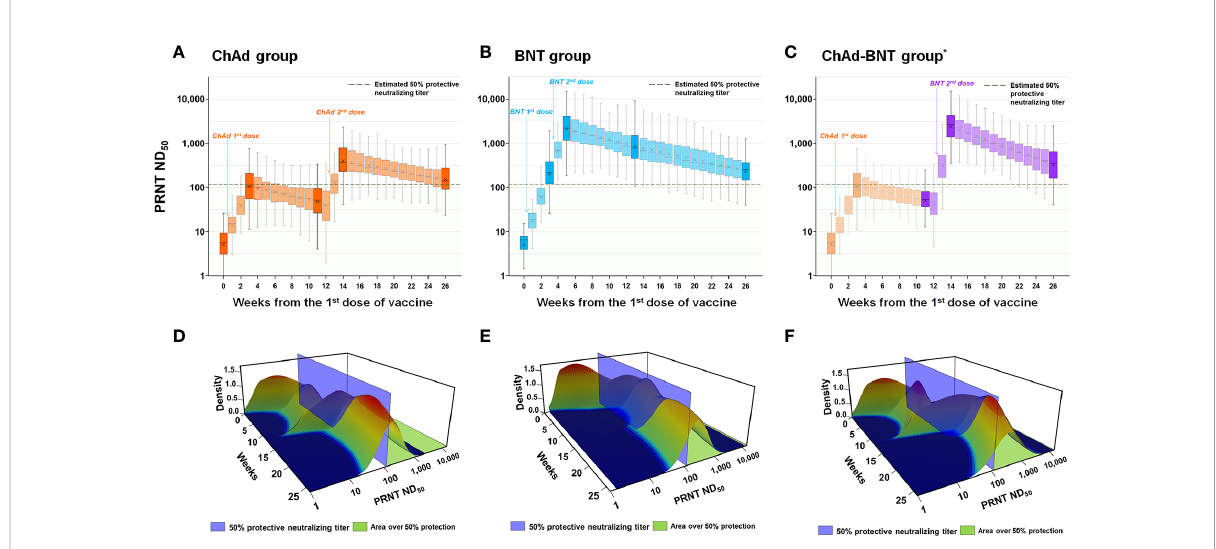
FIGURE 3 Estimation of protective immunity against WT SARS-CoV-2 for a 26-week period after vaccination. Individual PRNT ND 50 values were calculated for each week after the fi rst vaccine dose (transparent color) using the slope between the measured sampling points (dark color) and plotted for each vaccination group [ChAd (A) , BNT (B) , and ChAd-BNT (C) ]. The distributions of PRNT ND 50 titers for each week in ChAd (D) , BNT (E) , and ChAd-BNT (F) groups are presented using three-dimensional graphs. *Because the ChAd-BNT group was enrolled later, the baseline and week 3 antibody levels of the ChAd-BNT group were adopted from the ChAd group. WT, wild-type; SARS-CoV-2, severe acute respiratory syndrome coronavirus 2; PRNT, plaque-reduction neutralizing test; ND 50 , 50% neutralizing dose; ChAd, AZD1222 ChAdOx1 vaccine; BNT, BNT162b2